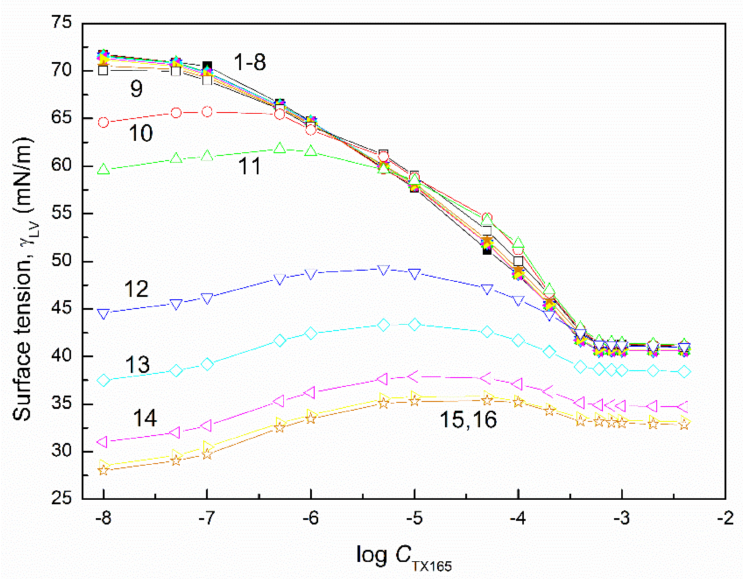
Figure 2. A plot of the surface tension ( γ LV ) of the aqueous solution of the RL and TX165 mixture vs. the logarithm of the TX165 concentration ( C TX165 ). Curves 1 − 16 correspond to the constant RL concentration equal to 0.0002, 0.0005, 0.00125, 0.003, 0.00625, 0.01, 0.02, 0.05, 0.1, 0.5, 1, 5, 10, 20, 30, and 40 mg/dm 3 , respectively.